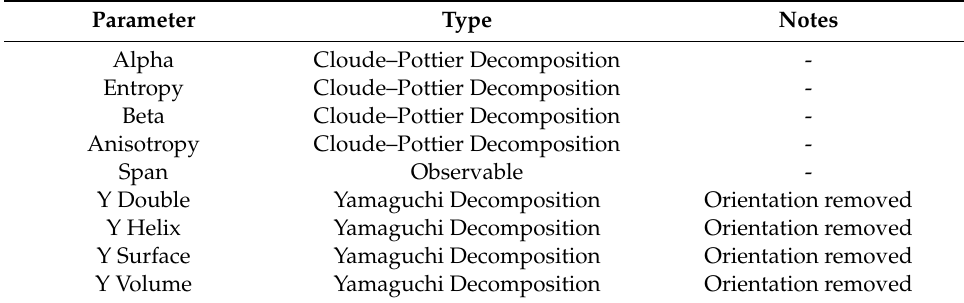
Table 2. Polarimetric parameters. Note the Yamaguchi parameters had their orientation removed and the span is a separate parameter that was deduced independent of a